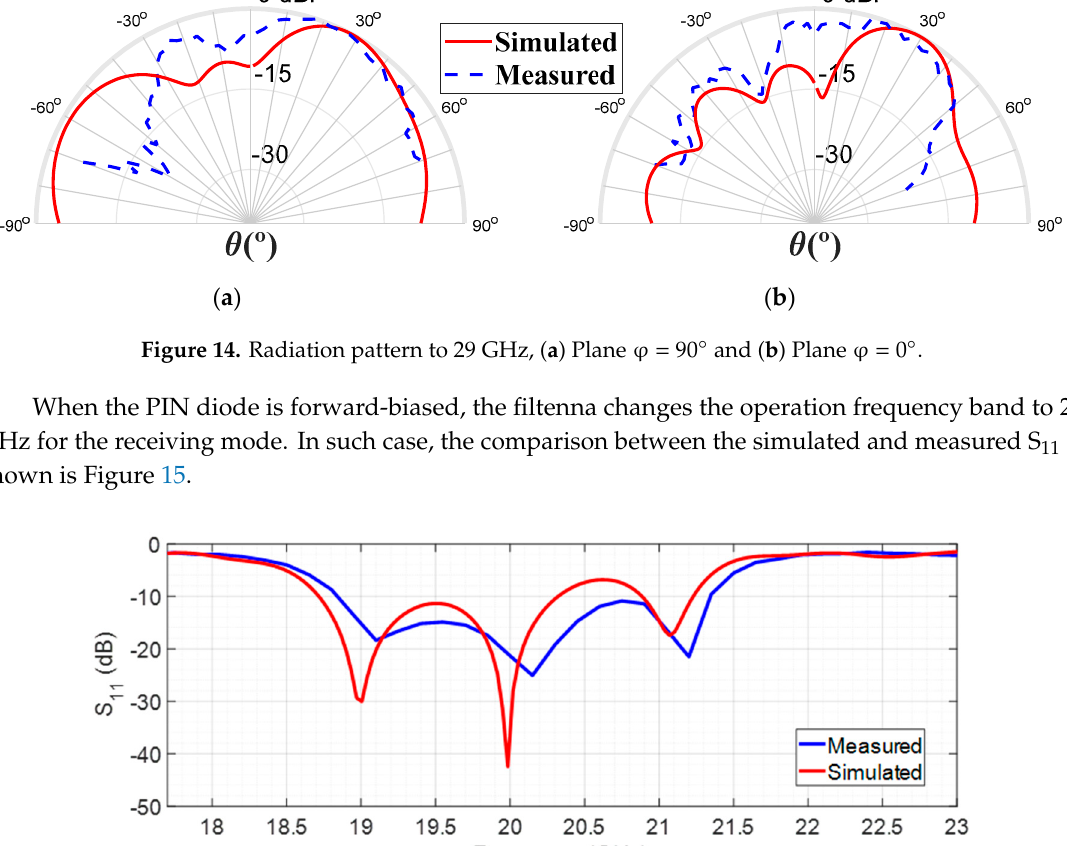
Figure 16. Radiation pattern to 20 GHz, ( a ) plane φ =90 ⁰ , and ( b ) plane φ =0 ⁰ .